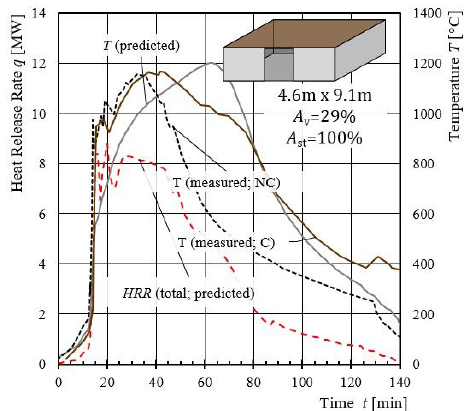
Figure 19: Predicted charring depth and modification factor α for considering the charring behaviour as function of time for the experiment IV.